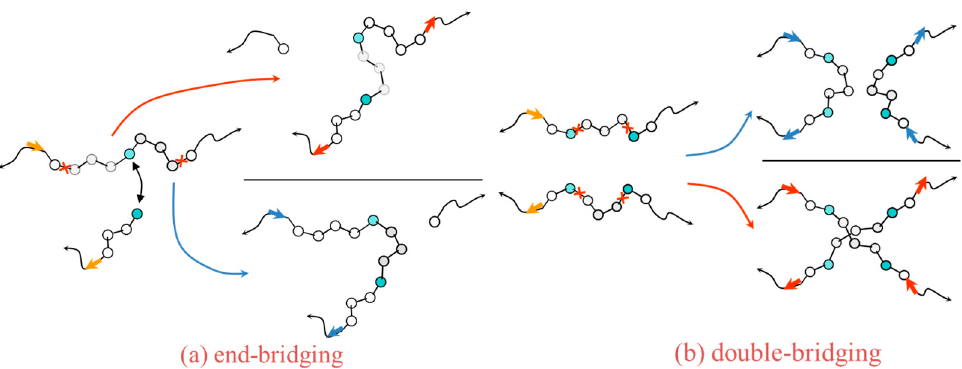
Figure 3. Illustration of the ( a ) end-bridging and ( b ) double-bridging MC moves designed to be implemented for polymeric chains with directionality in their chemical structure. In each case, the moves shown by blue arrows are possible. Intramolecular double-bridging MC moves cannot be performed in the case of directional chains.